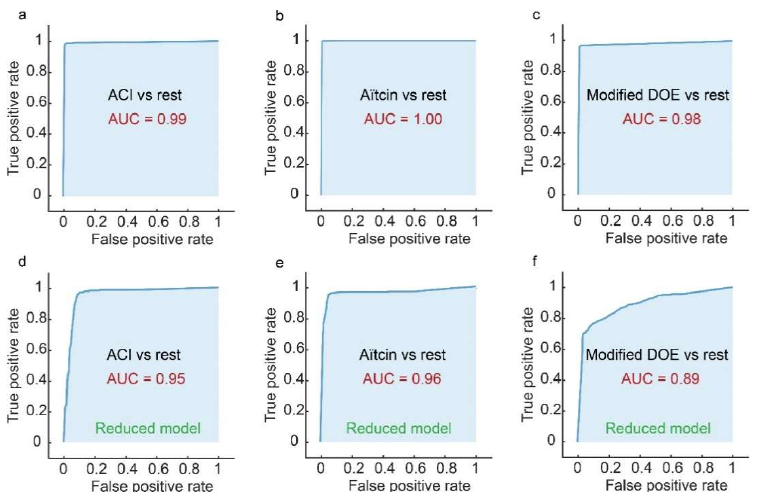
Figure 4. Evaluating the performance of the tree classifier on training data. ( a ) ROC curve of ACI method versus Aïtcin and modified DOE. ( b ) Aïtcin method versus ACI and modified DOE. ( c ) Modified DOE method versus ACI and Aïtcin. Similar ROC curves are shown in ( d – f ), however, for the case when reduced-dimensionality tree models are used.